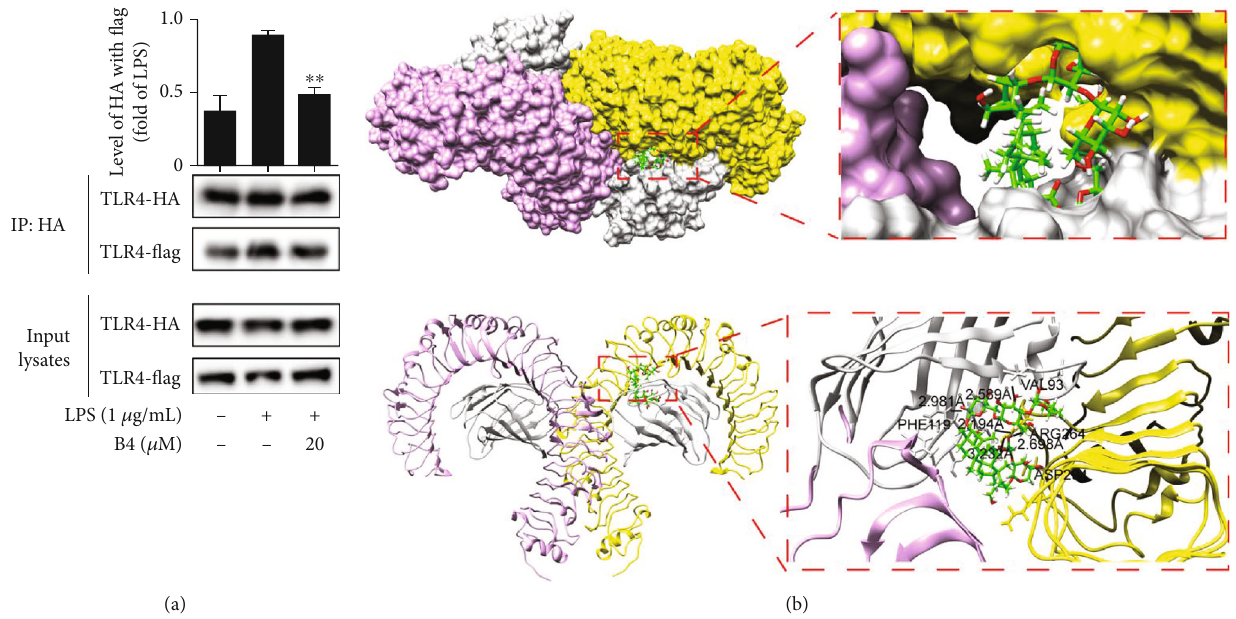
Figure 4: B4 blocked TLR4 dimerization. (a) The two plasmids TLR4-HA and TLR4-Flag were cotransfected into HEK293T cells for 24h, then pretreated with B4 for 1 h, and cultured with LPS for 12h. Cells were harvested, and Western blotting was used to analyze the formation of TLR4 dimerization. The experiments were performed three times independently. (b) The molecular docking data of B4 on TLR4-MD-2 dimer were analyzed by using LeDock software. The molecular docking data of B4 with TLR4-MD-2-LPS complex (PDB code: 3FXI) was performed in LeDock (http://www.lephar.com). TLR4-MD-2-LPS complex structures were obtained from the RCSB Protein Data Bank (PDB code: 3FXI). ∗∗ P < 0 : 01 compared to the LPS